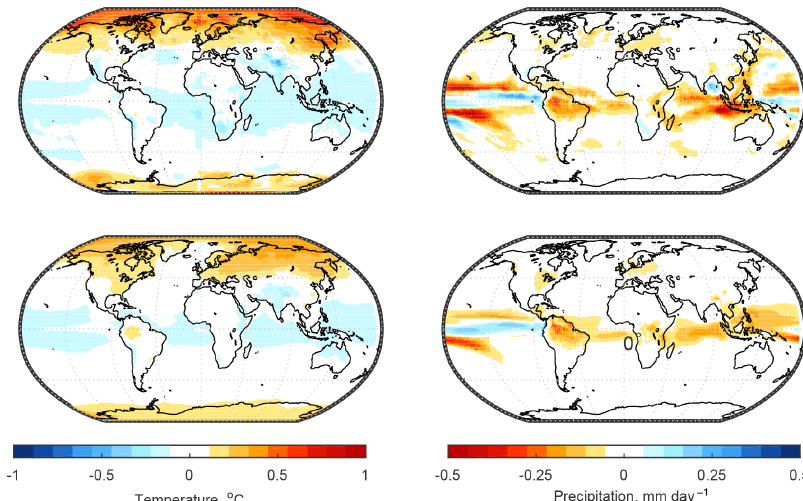
Figure 7. Temperature (left) and precipitation (right) averaged over years 41–50 of the G2 simulation and averaged over all nine models. The upper panels show the simulated results; the lower panels show the prediction based on a spatial emulator developed using four EOFs for each model. As noted elsewhere, the robust response to increasing CO 2 and reducing insolation to maintain zero global-mean temperature difference is a net reduction (overcompensation) of global-mean precipitation (Bala et al., 2010), and an overcooling of the tropics and an undercooling of the poles (Kravitz et al., 2013). The latter is an artifact of a latitudinally uniform reduction in sunlight, and could be better managed by increasing the forcing at high latitudes relative to low (Kravitz et al.,